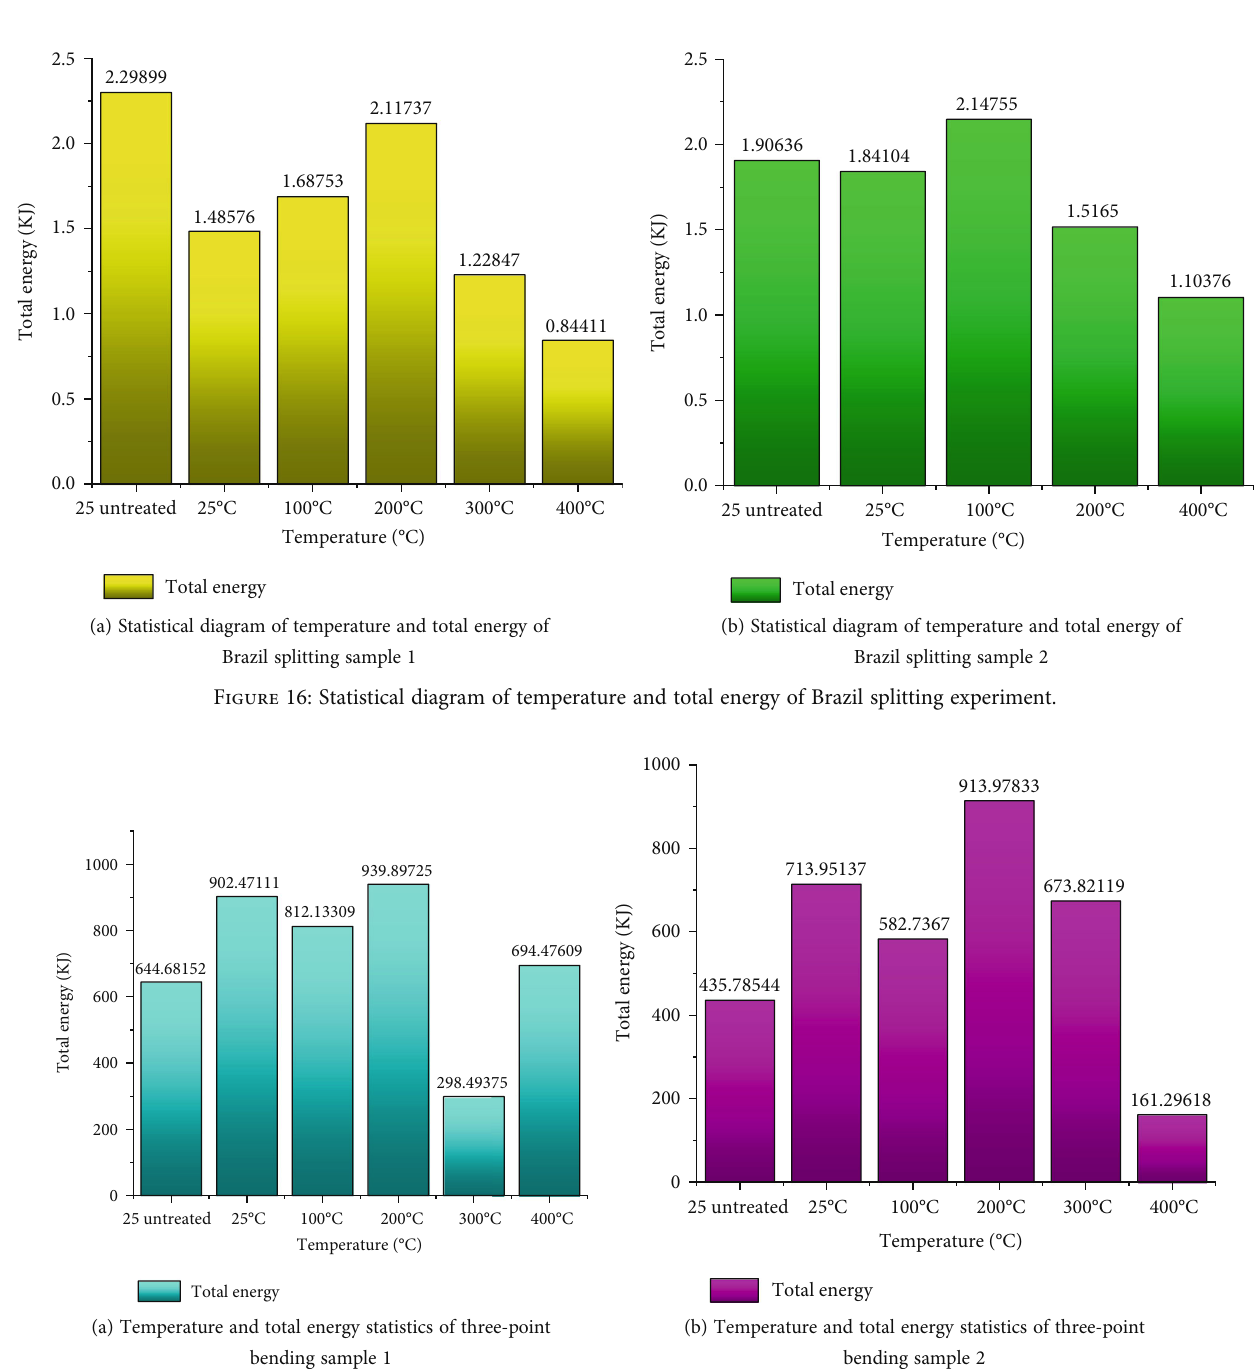
Figure 17: Temperature and total energy statistics of three-point bending